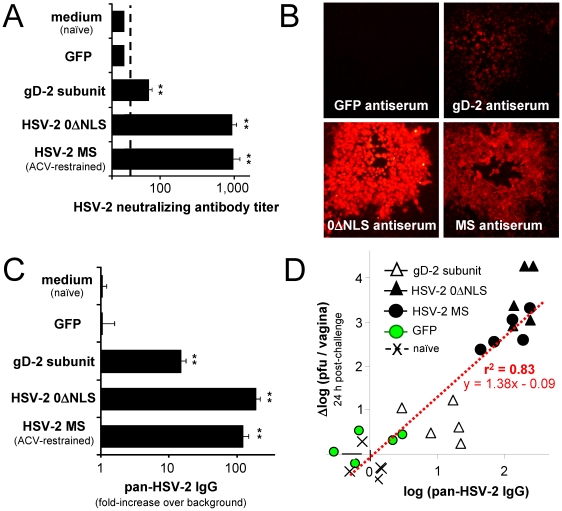
Polyclonal HSV-2 IgG antibody response elicited by HSV-2 0ΔNLS, gD-2, or control immunogens.(A) Mean ± sem neutralizing antibody titer of Day 60 serum samples (n = 20 per group). The titer of each serum sample was considered to be the reciprocal of the largest serum dilution that reduced HSV-2's cytopathic effect in Vero cell monolayers by at least 50%. (B) Representative immunofluorescent labeling of fixed HSV-2 plaques with a 1∶5,000 dilution of Day 60 serum from each immunization group. (C) Flow cytometric measurement of pan-HSV-2-specific IgG levels in Day 60 sera, as determined by IgG binding to fixed HSV-2-infected cells versus uninfected Vero cells (n = 8 per group). In panels A and C, a double asterisk (**) denotes p<0.001 that neutralizing antibody titers or pan-HSV-2 IgG levels were equivalent to naïve mice, as determined by one-way ANOVA and Tukey's post hoc t-test. The difference in pan HSV-2 IgG levels between 0ΔNLS- and gD-2-immunized mice was significant (p<0.0001; two-sided, paired t-test). (D) Regression analysis of the logarithm of pan-HSV-2 IgG levels (x-variable, as measured on Day 60) in n = 25 mice versus the logarithmic reduction in vaginal HSV-2 MS shedding (y-variable, as measured on Day 81) observed in the same n = 25 mice at 24 hours post-vaginal challenge. The x-variable data is based on a subset of the data summarized in Figure 5C, and likewise the y-variable data is based on a subset of the data summarized in Figure 4C. The individual datum points are derived from n = 5 mice per group that were immunized with medium (naïve), GFP, gD-2, HSV-2 0ΔNLS, or HSV-2 MS (ACV-restrained infection), as indicated in the legend in Panel D. The quantity on the y-axis, Δlog (pfu/vagina), represents the logarithmic decrease of HSV-2 MS shed from an individual mouse vagina at 24 hours post-challenge relative to 5.20 logs, which was the average titer of HSV-2 MS shed by naïve mice at 24 hours post-challenge. The goodness-of-fit of the correlation between log (pan-HSV-2 IgG) and Δlog (pfu/vagina) was r2 = 0.83 and the slope of the correlation was 1.38±0.13 (p<10−9).